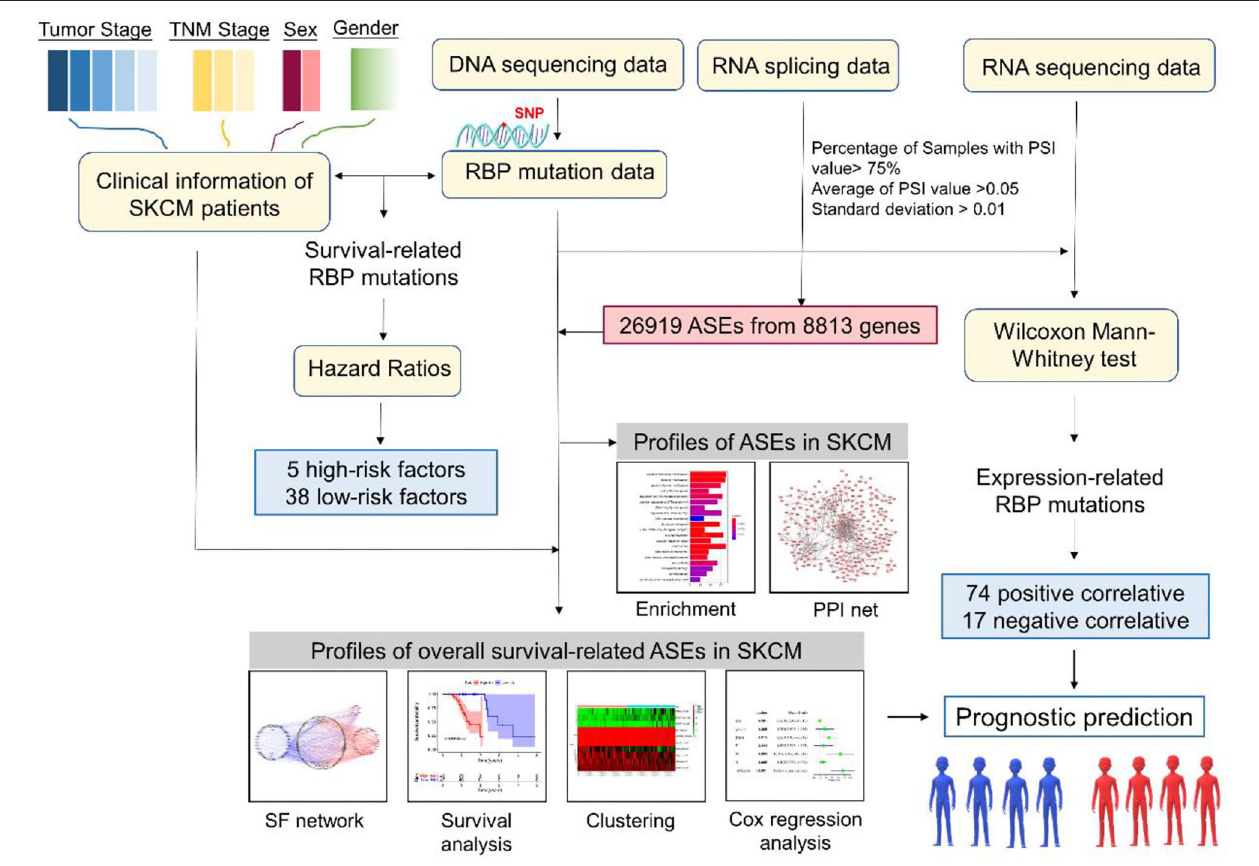
FIGURE 1 | Flow diagram of the research methodology. RBP, RNA-binding protein; ASE, alternative splicing event; SF, splicing factor; PPI, protein–protein